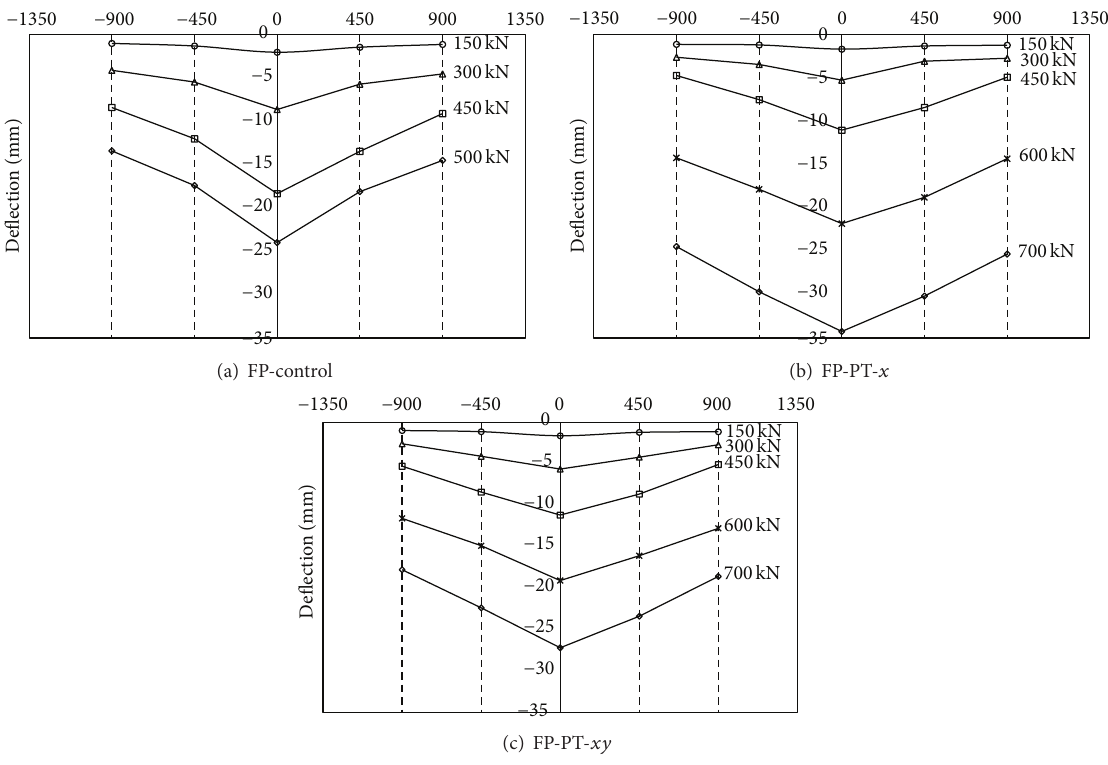
Figure 6: Deflection profiles of the